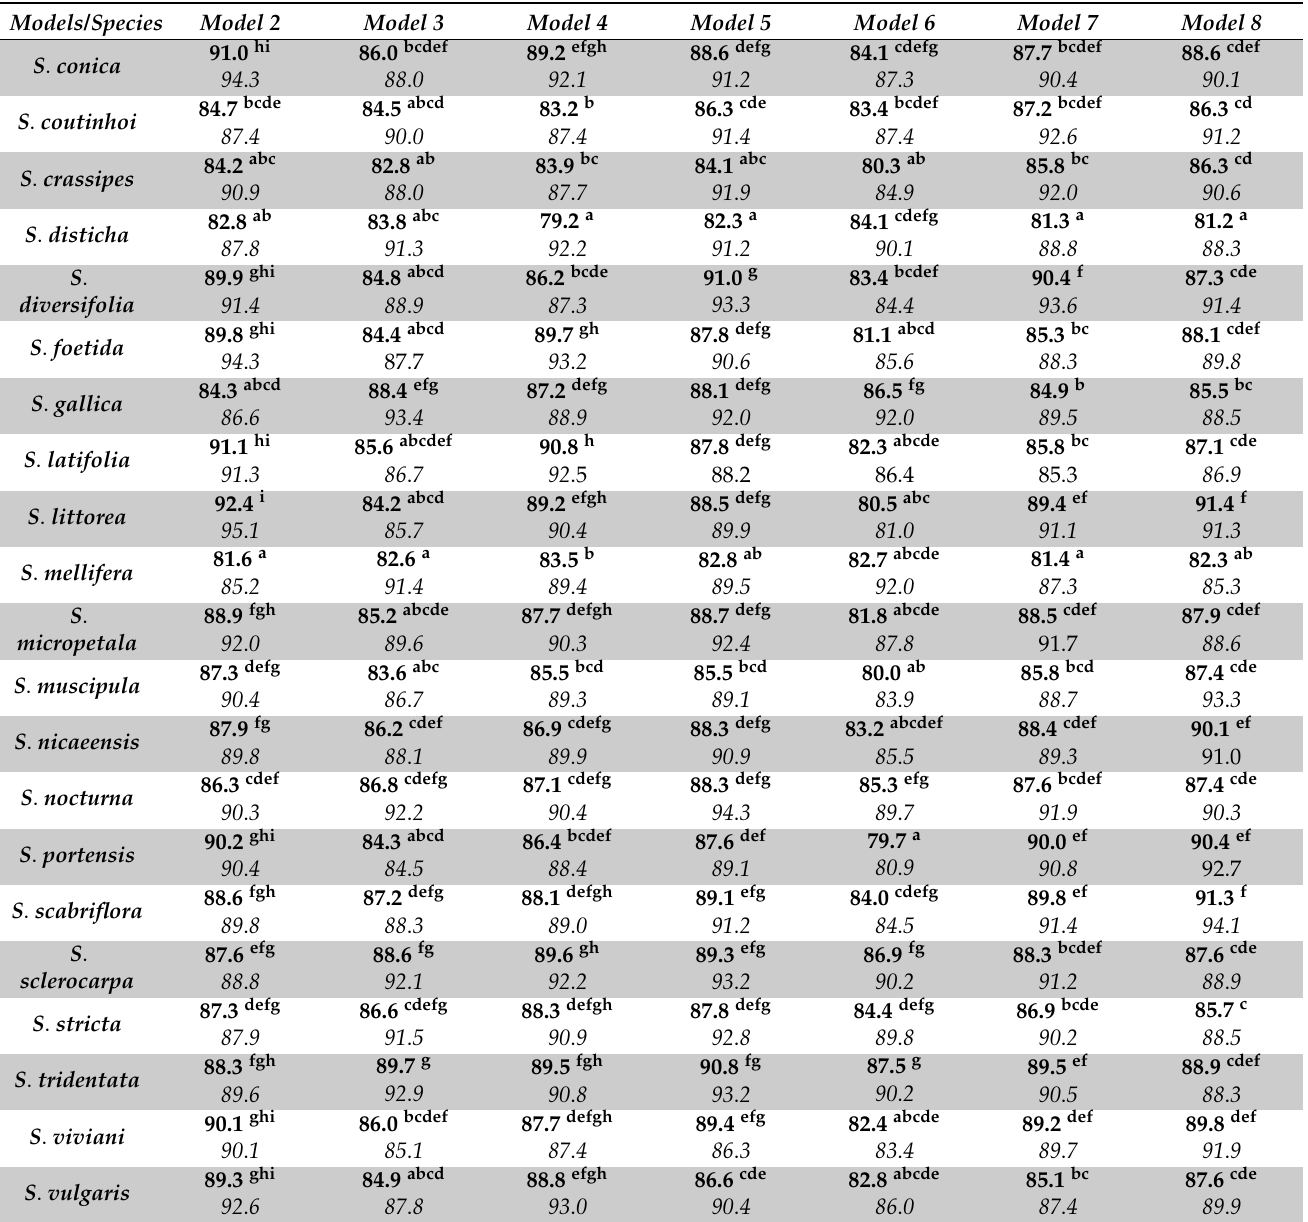
Table 7. Values of J index obtained with models 2 to 8 of the different Silene species. Numbers in bold correspond to mean values obtained as a mean value of 20 seeds. Numbers in cursive correspond to data obtained by comparison with the average silhouette for each species. Superscript letters indicate the results of Scheff é test: the mean values marked with a different letter in each column differ significantly at p <